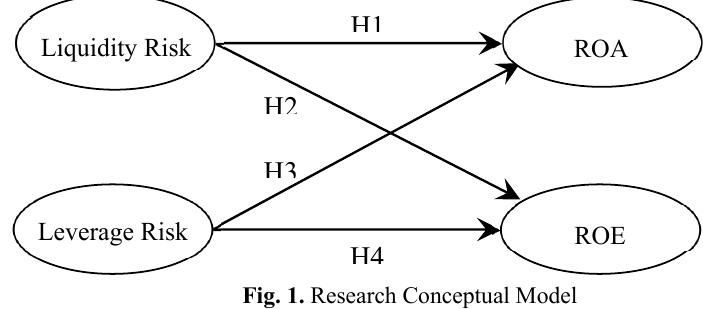
Fig. 1. Research Conceptual